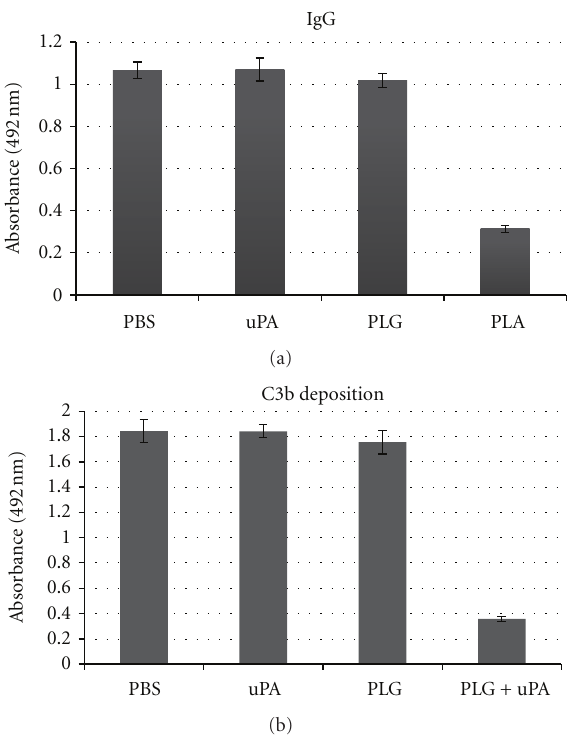
Figure 10: Human IgG and C3b binding to L. interrogans. Bacteria were coated onto microtiter plates (25 × 10 6 leptospires/well) and IgG (a) or C3b (b)were bound by incubating bacteria with 100% NHS. Bacteria were treated with PBS, 40 μ g/mL PLG (PLG), 5 μ g/mL uPA (uPA), or PLG + uPA (Pla). Presence of human IgG or C3b deposited on leptospires was determined by ELISA. Bars represent the mean absorbance values at 492 nm ± the standard deviation of three replicates for each experimental group and are representative of two independent